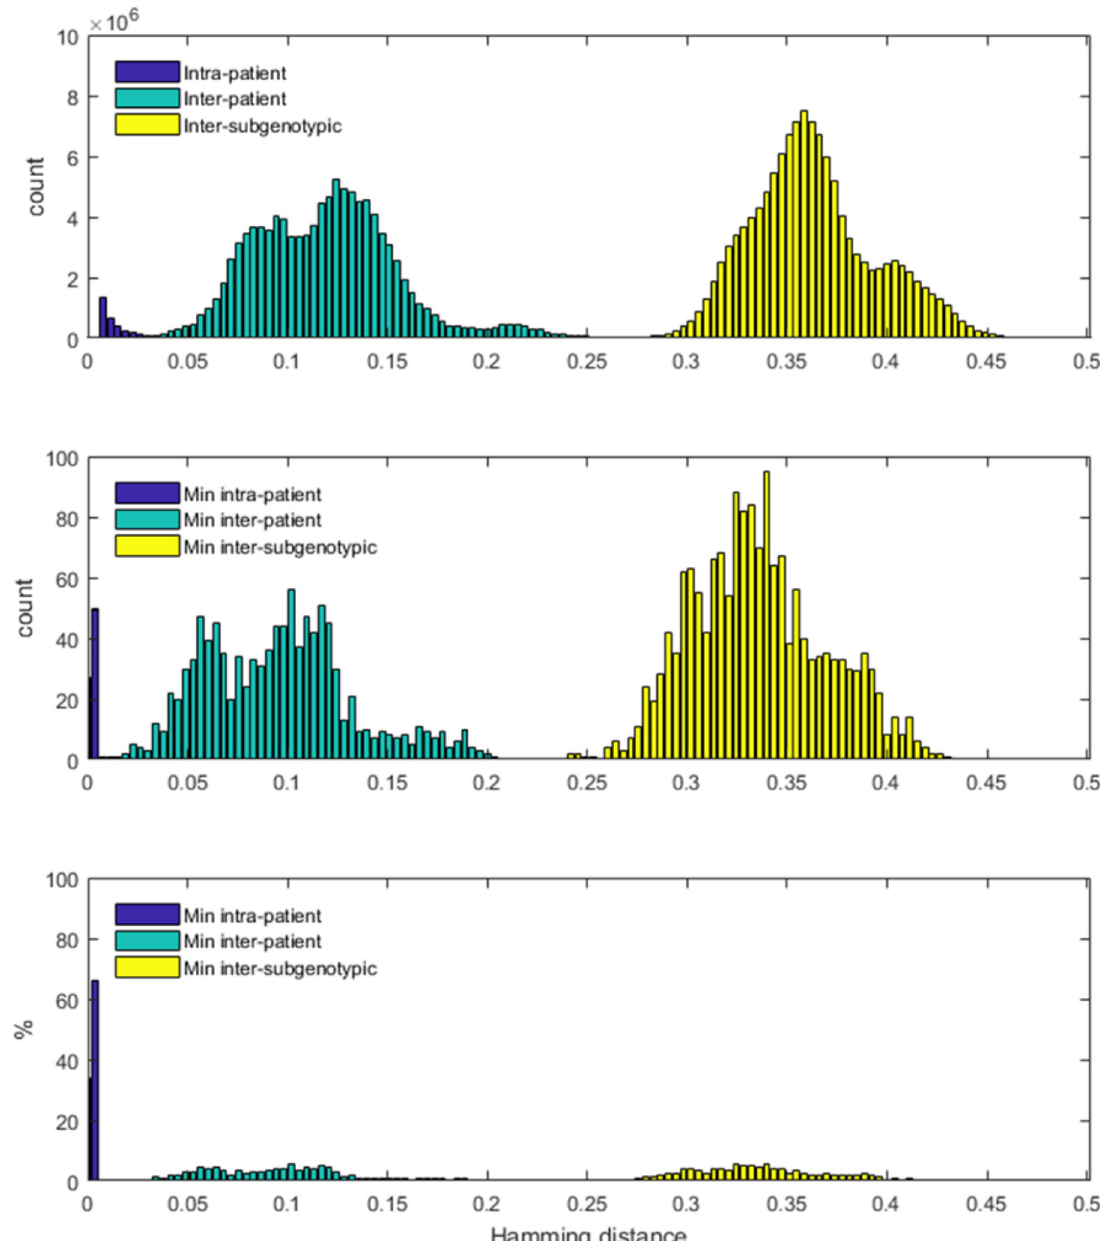
Fig 4. Genetic distances between and within patients and subtypes. Histograms of pairwise Hamming distances among samples. In all panes, the x-axis displays the distance, and the y-axis displays the count/percentage of pairs found to have that distance. Distances within a patient are denoted by blue; distances between patients from the same subgenotype are denoted by green; distances between patients from different subgenotype are denoted by yellow. (A) All distances between the sequences in the three groups. The y-axis represents the count of the pairs found at a certain Hamming distance. (B) Minimum pairwise distances in the three groups. For each pair of patients in the group, the minimum distance is defined as the minimum distance between the sequences of the two patients. The y-axis represents the count of the pairs with this minimum Hamming distance. (C) Percentage of the minimum distances between patients in the three groups respective to all minimum distances found in the group.